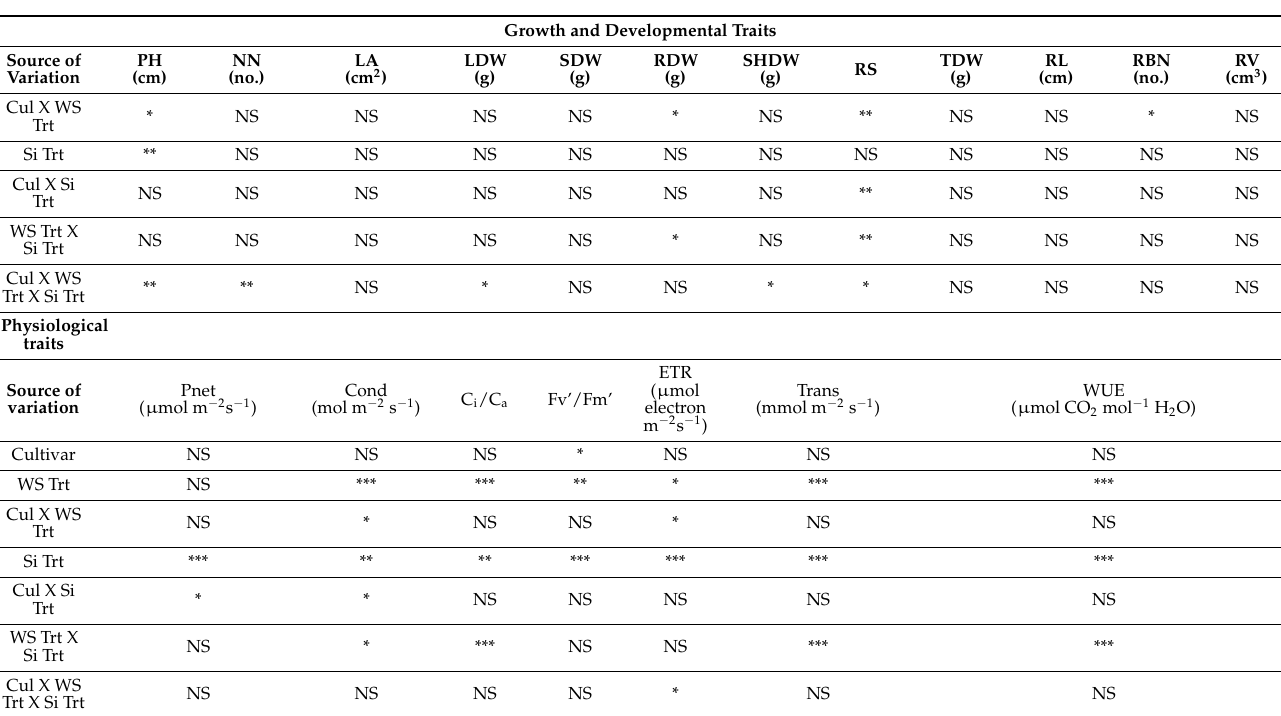
Table 2. Cont. Growth and Developmental